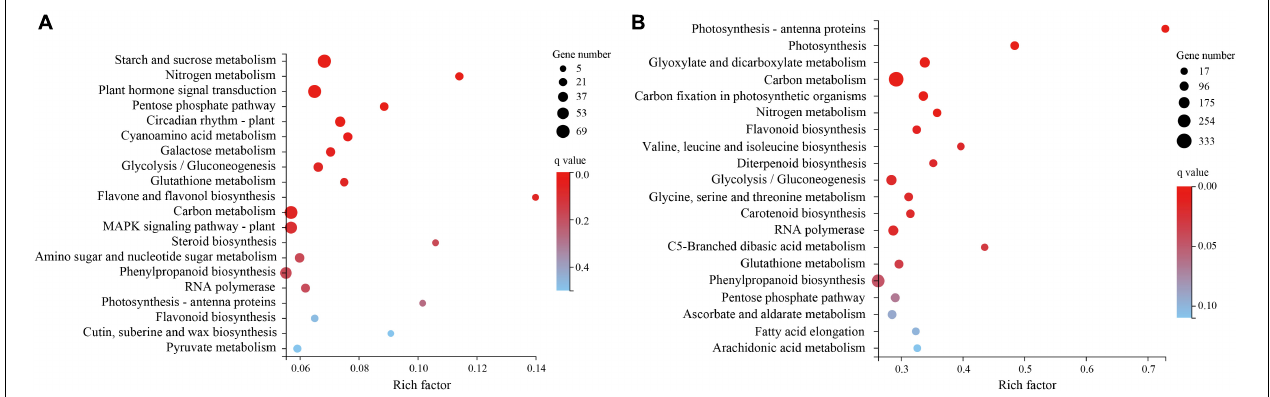
FIGURE 4 | KEGG pathway enrichment with differentially expressed genes (DEGs) between different droughts treated. (A) KEGG pathway enrichment of DEGs to drought stress in T1. (B) KEGG pathway enrichment of DEGs to drought stress in T2.